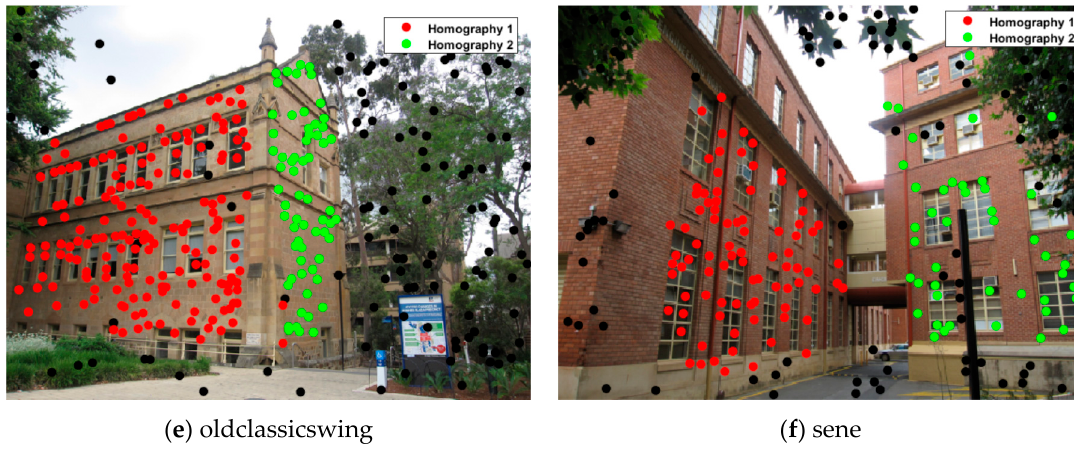
Figure 7. Inlier segmentation results for the multi-homography estimation.